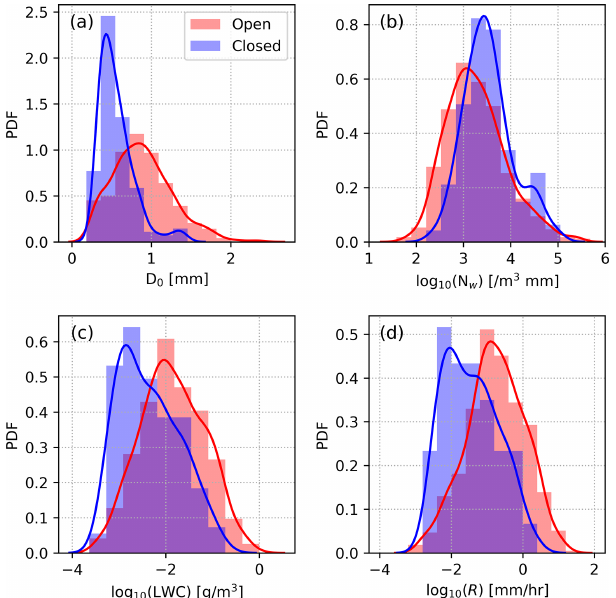
Figure 10. Comparison histograms of precipitation drop size dis- tribution parameters: (a) median volume drop size ( D 0 ), (b) DSD intercept parameter ( N w ), (c) liquid water content and (d) rain rate (RR) for open- and closed-cell cases. The lines are the probability density functions (PDFs) calculated using Gaussian kernel density estimation.